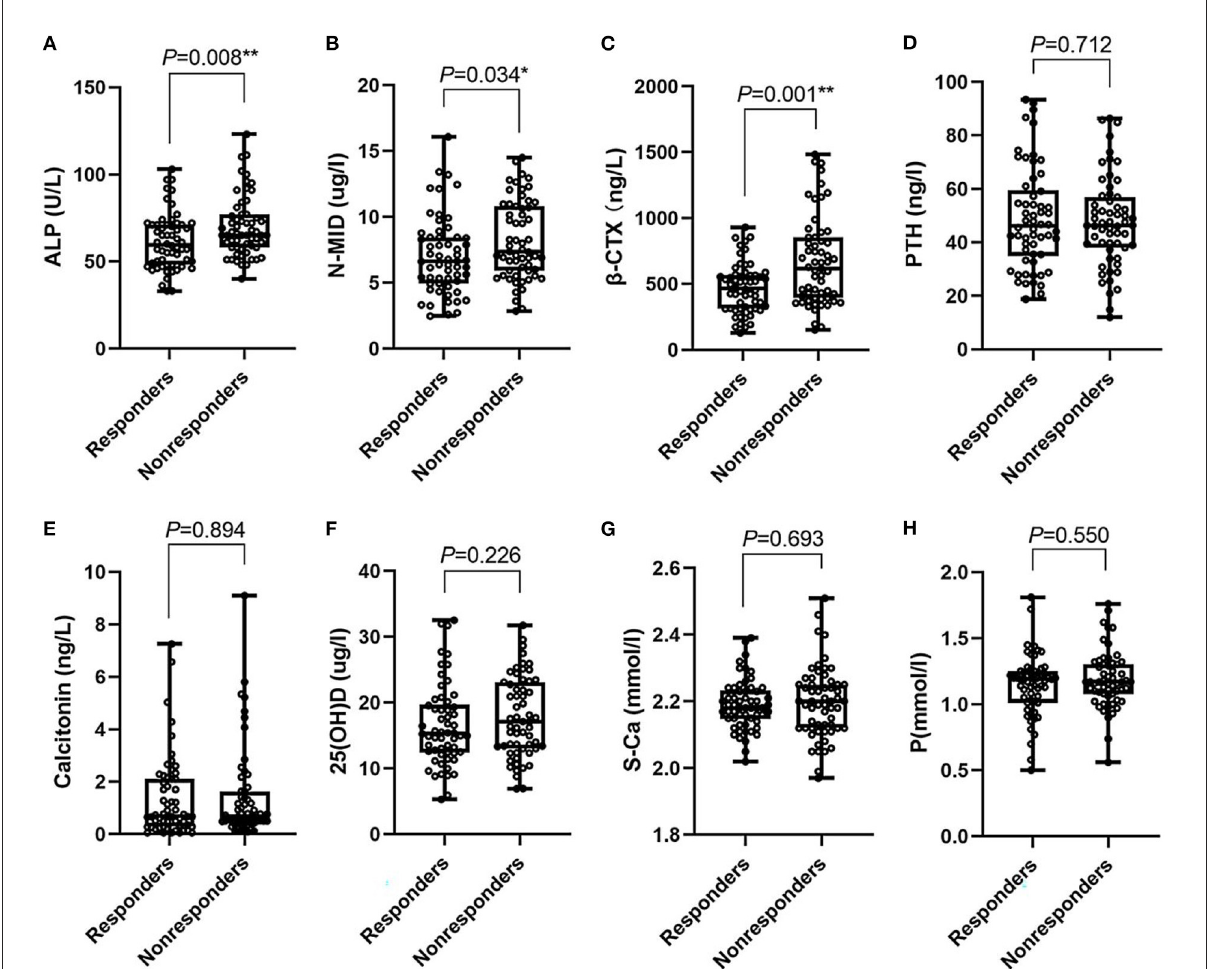
FIGURE1 Box-plot. (A–H) Represent the median (min-max) of ALP, N-MID, β -CTX, PTH, calcitonin, 25(OH)D, S-Ca, P in responders and nonresponders, respectively. ALP, Alkaline phosphatase; N-MID, N-terminal-midfragment of osteocalcin; β -CTX, β -carboxy terminal crosslinked telopeptide